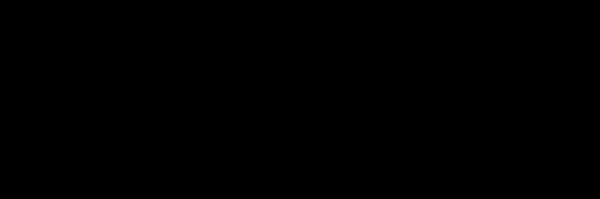
Influence of the personal characteristics on entrepreneurial intention. LOC, locus of control; NACH, Need for achievement; RT, Risk-taking; CA, Creativity; EINT, Entrepreneurial intention.